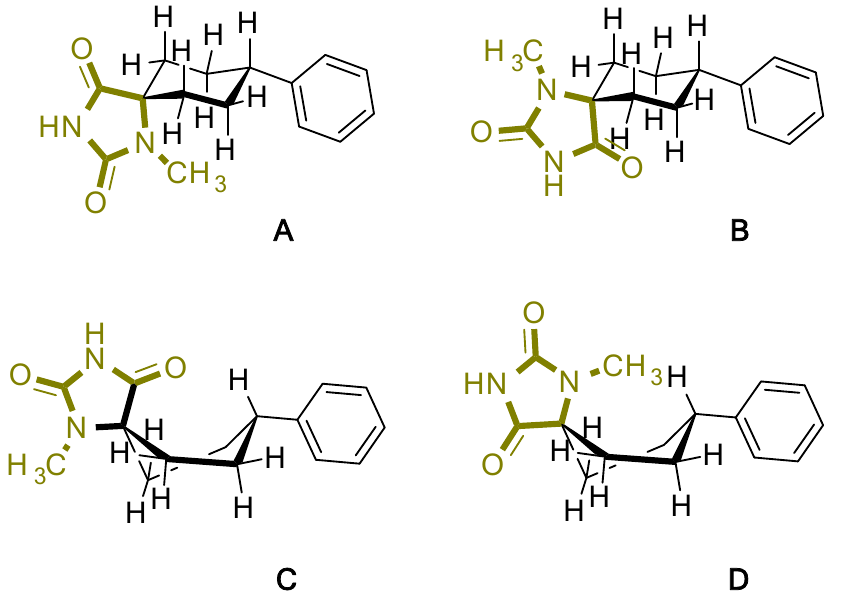
Figure 2. Chemical structure representation of compound ( 4 ) conformations ( A – D ). Table 1. DFT summary of the calculated 4 conformations A – D. Compound